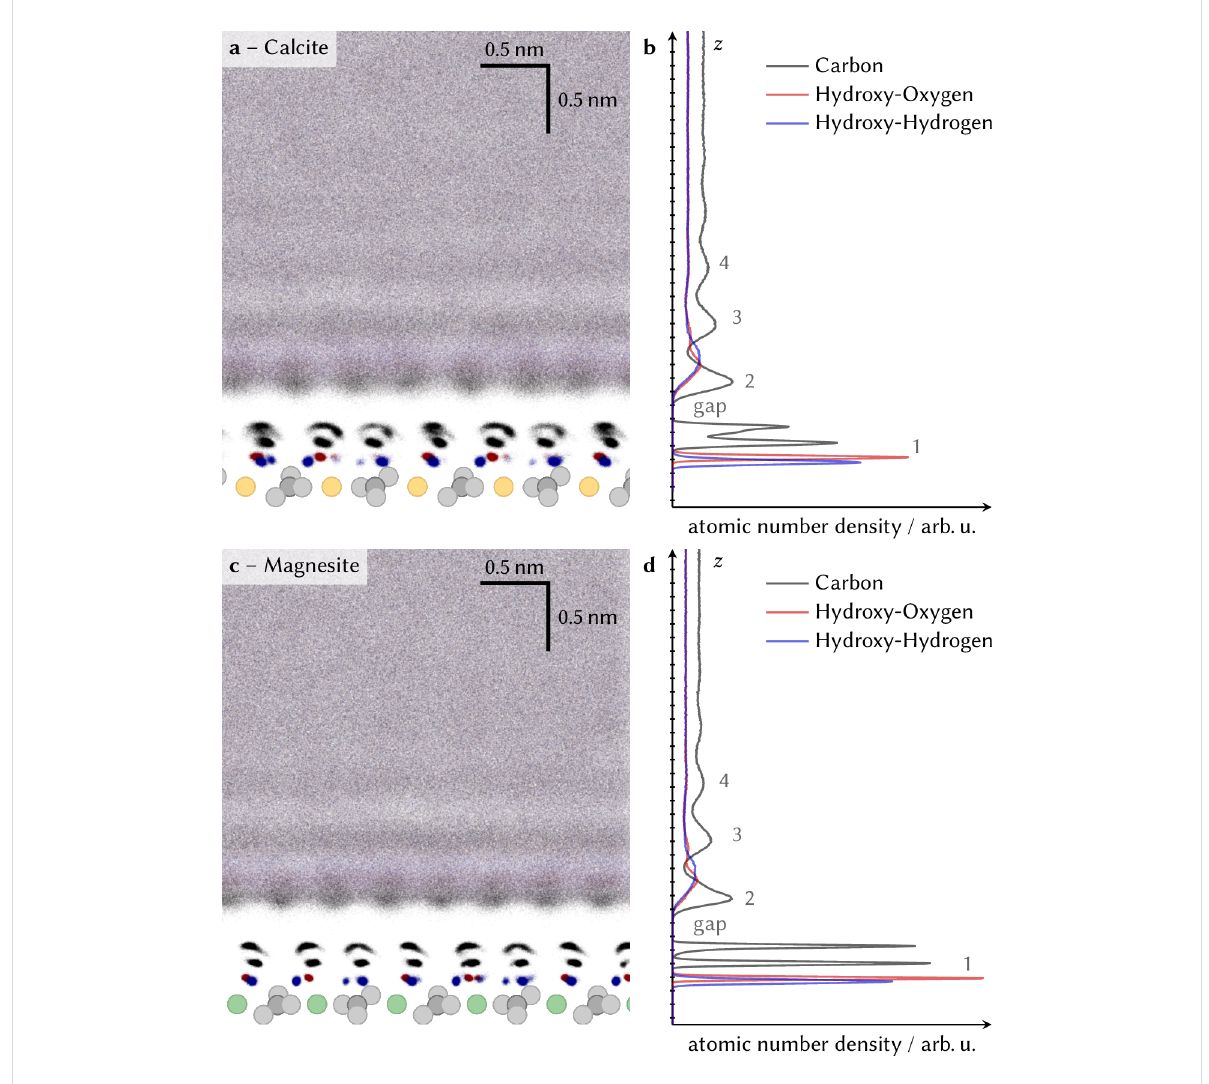
Figure 2: Vertical slices showing the atomic positions of ethanol–carbon (black), hydroxy–oxygen (red) and hydroxy–hydrogen (blue) at the (a) calcite–ethanol and (c) magnesite–ethanol interface. The graphs were created by drawing a semi-transparent dot for each atom at each time step of the simulation. The surfaces are represented by the carbonate groups (grey) and calcium (yellow) and magnesium (green) spheres, respectively. (b and d) Corresponding averaged density profiles are shown in the graphs to the